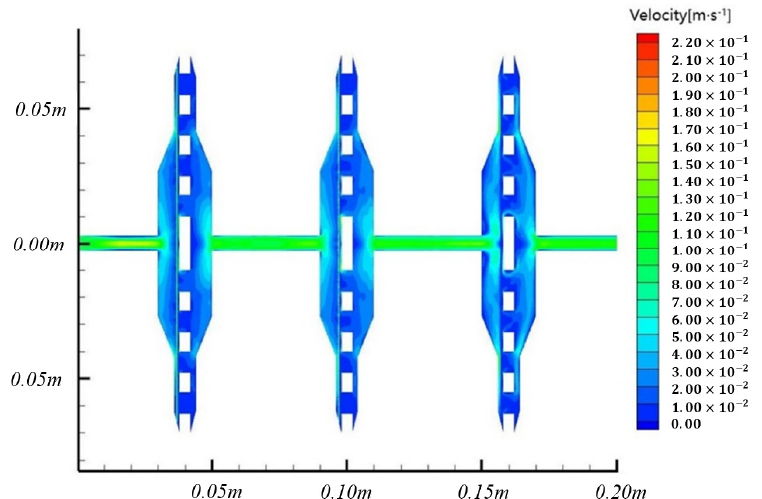
Figure 6. Flow velocity cloud image inside the system.